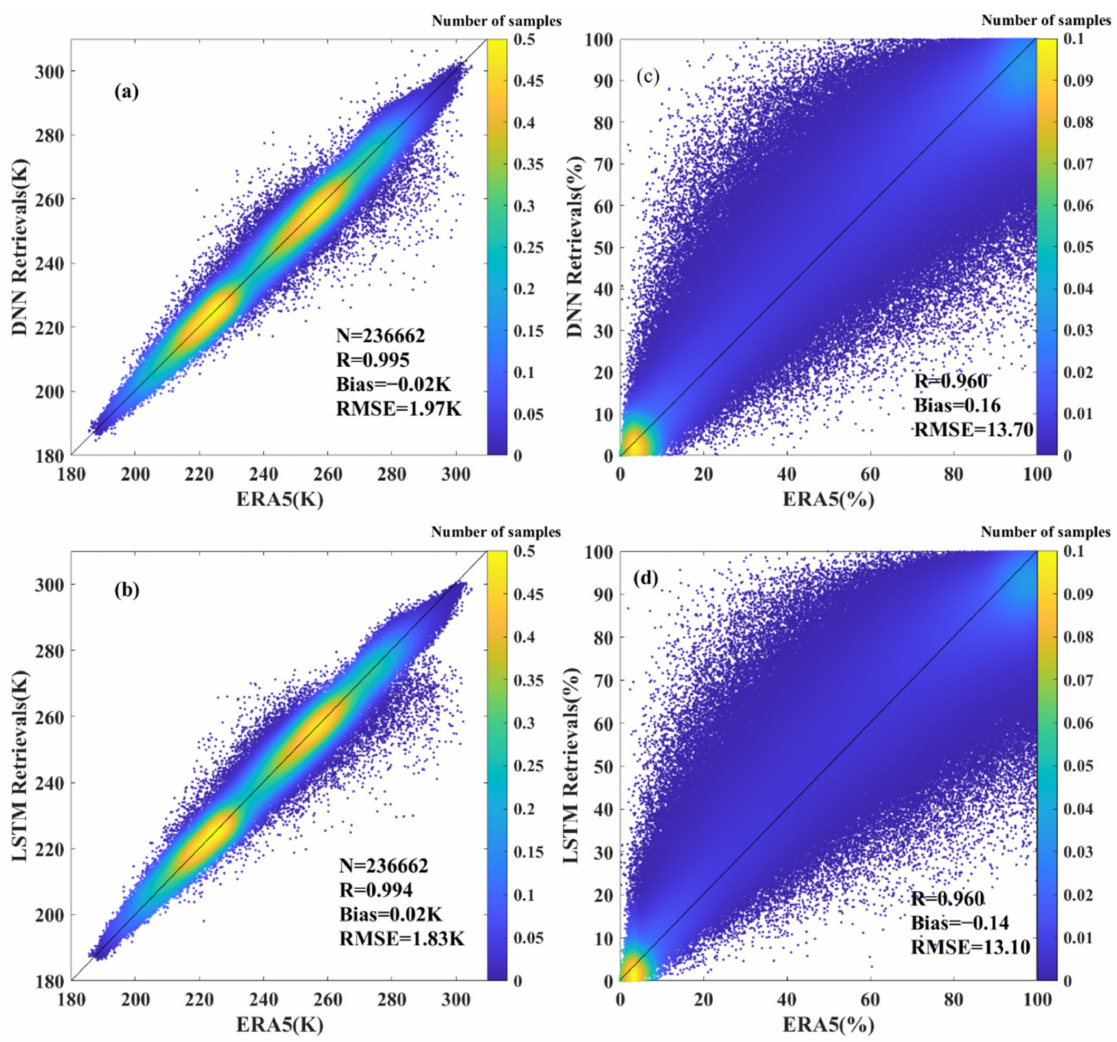
Figure 8. The retrieval results of the DNN and LSTM models versus the ERA5 over land using the validation dataset in June 2021, the black lines represent the diagonal y = x . ( a , b ) are the temperature retrieval results of the DNN model and LSTM model, respectively. ( c , d ) are the atmospheric humidity retrieval results of the DNN model and LSTM model,